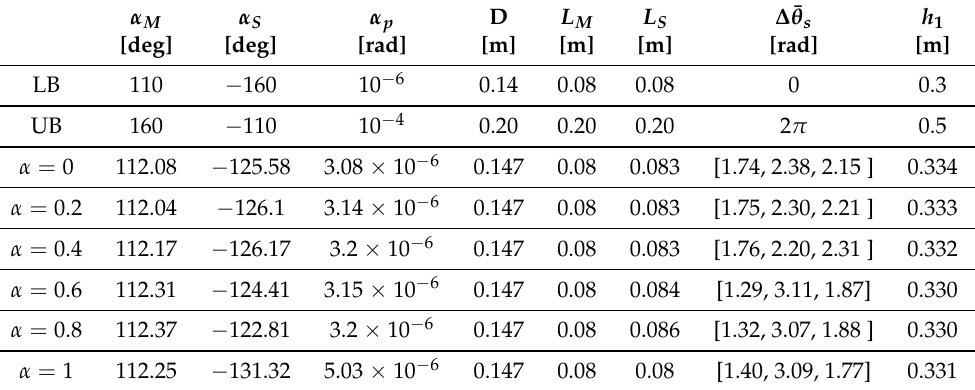
Table A3. The resulting (optimized) parameter values of co-design case 3 given variable weight α .